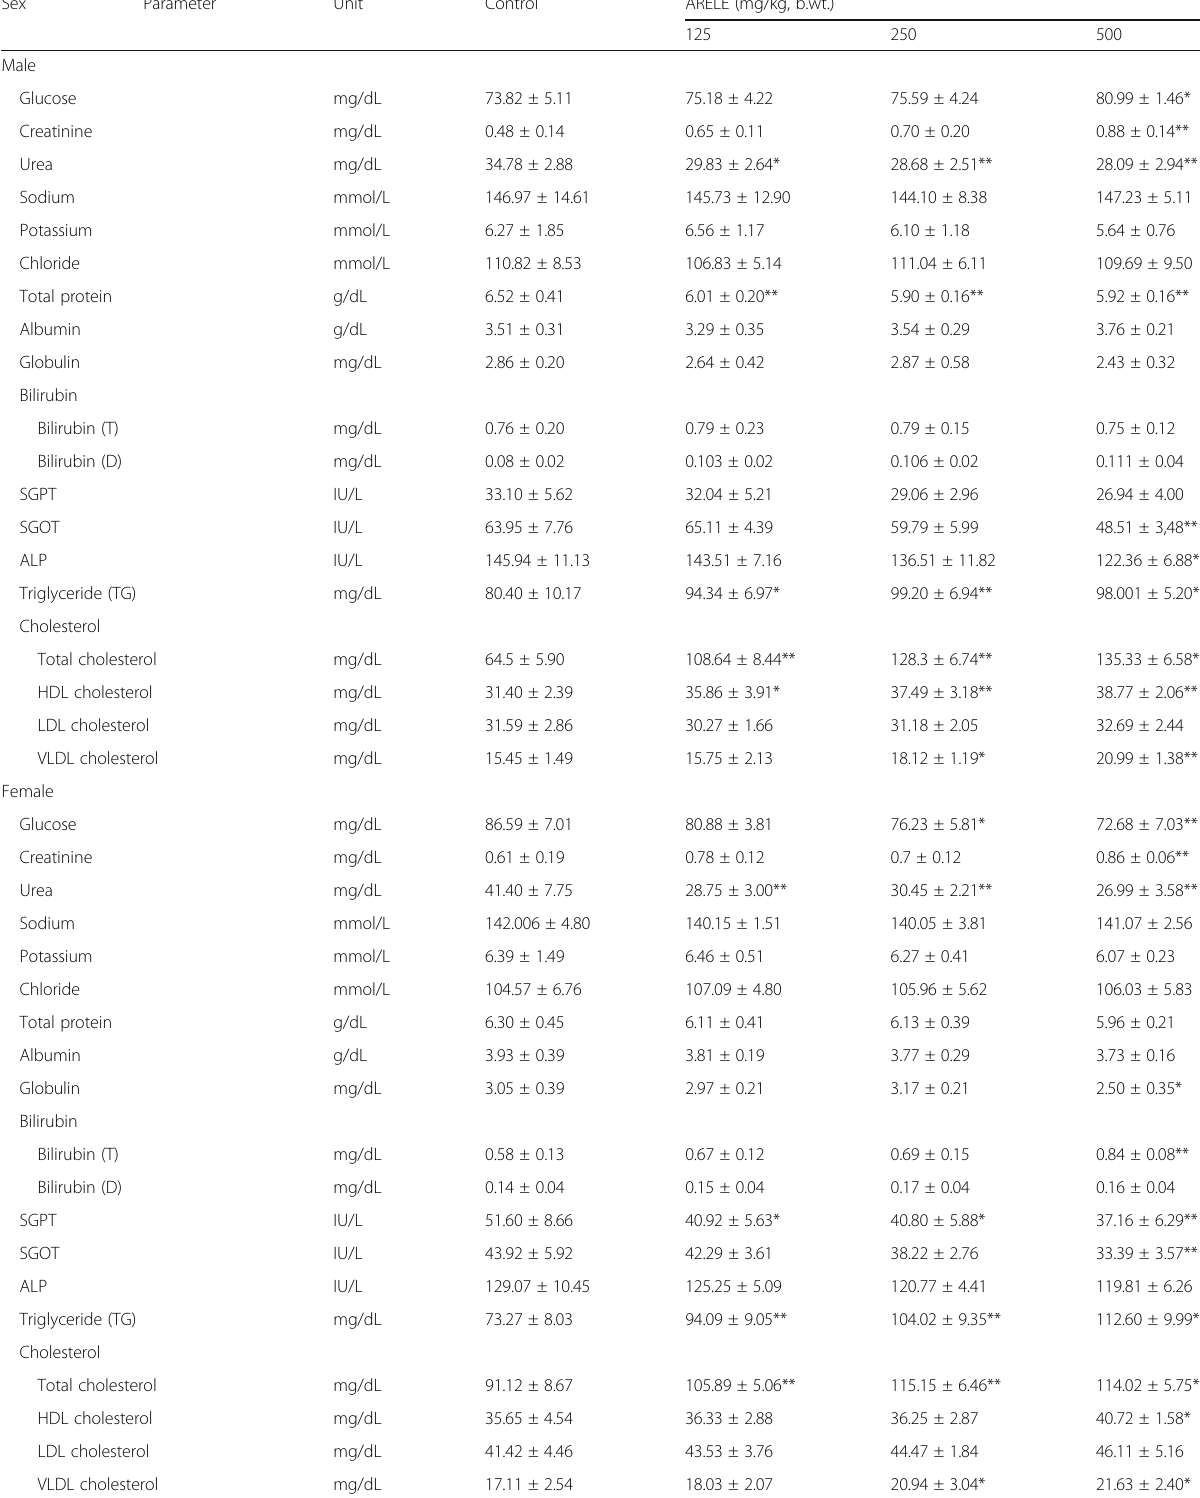
Table 3 Effects of ARELE on biochemical parameters in both male and female rats treated for 30